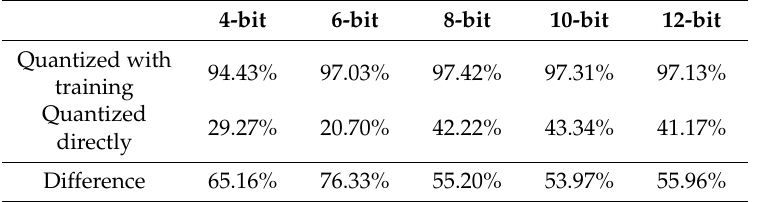
Table 6. Accuracies of directly quantized models and quantized models with training.